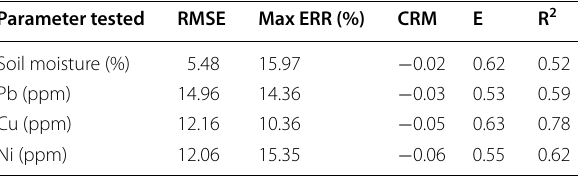
Table 2 Calibration results of the model based on various statistical indicators Parameter tested